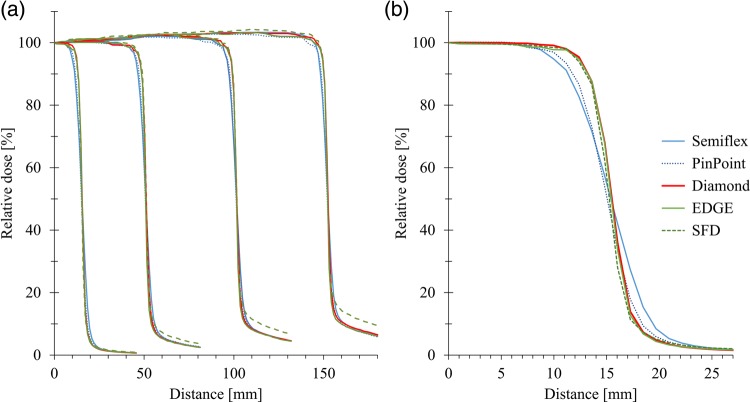
(a) Profiles of 6-MV photon beams of 3 × 3 cm2, 10 × 10 cm2, 20 × 20 cm2, and 30 × 30 cm2 field size measured at dmax. (b) Profiles of 3 × 3 cm2 field size are focused. Note the diamond detector provides a superior profile.